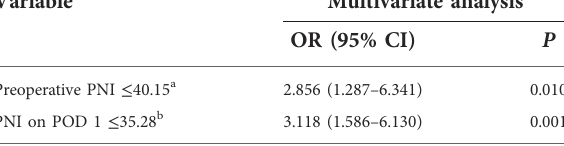
TABLE 2 Univariate analysis of risk factors associated with surgical complications.